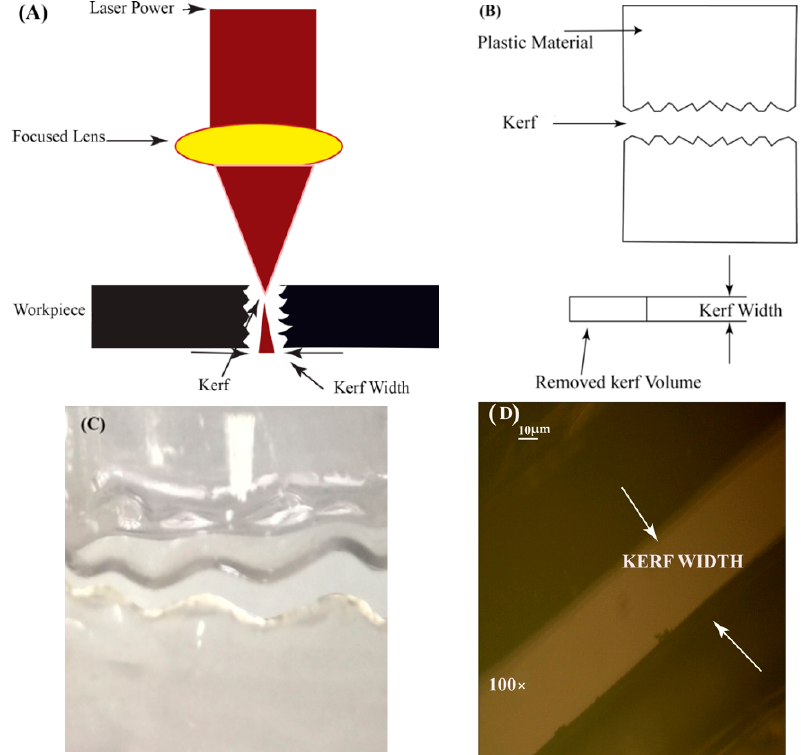
Figure 3. Schematic illustration of the cut material and its kerf formation ( A , B ): Schematic illustration of kerf and kerf width, ( C ): Physical representation of KW, and ( D ): Microscopic analysis of kerf width.